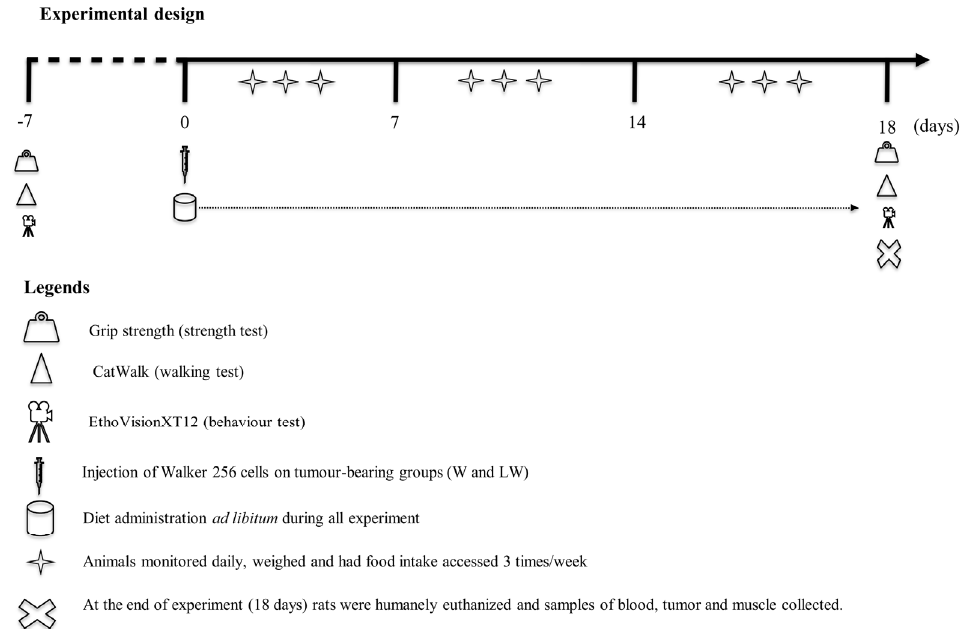
Figure 1. Experimental design. Male adult Wistar rats were monitored daily, weighed three times/week, and given food (control or leucine-rich diets) and water ad libitum. Food intake was measured three times/week, and the functional activities were accessed one week before (to access the health condition) and 18 days after tumour evolution and diet administration.